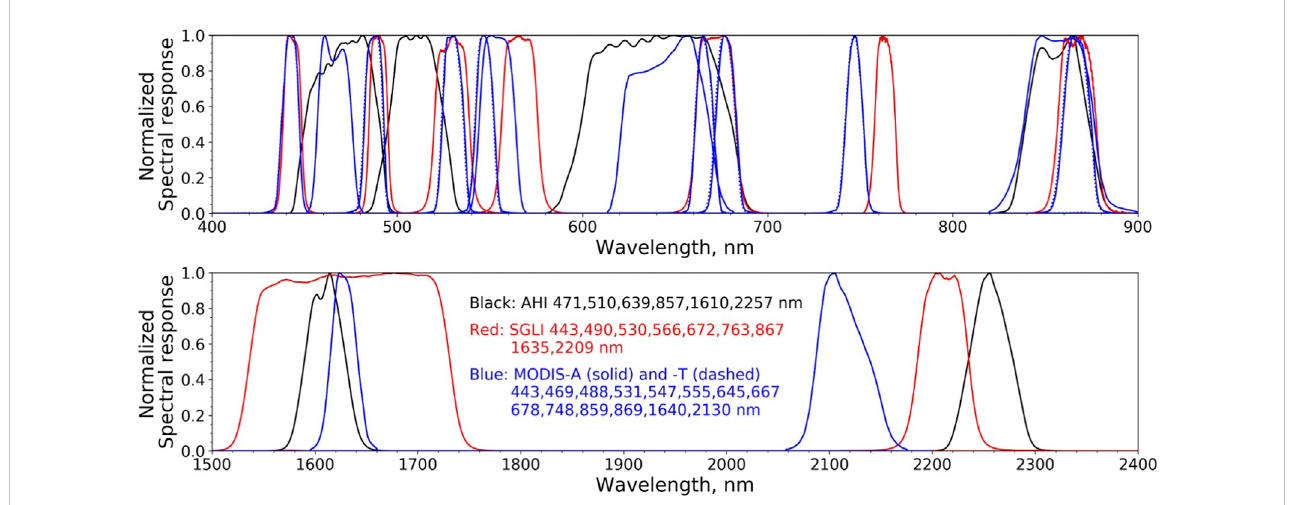
FIGURE 1 Normalized spectral response of AHI (black), SGLI (red), MODIS-A (blue solid), and MODIS-T (blue dashed) bands.